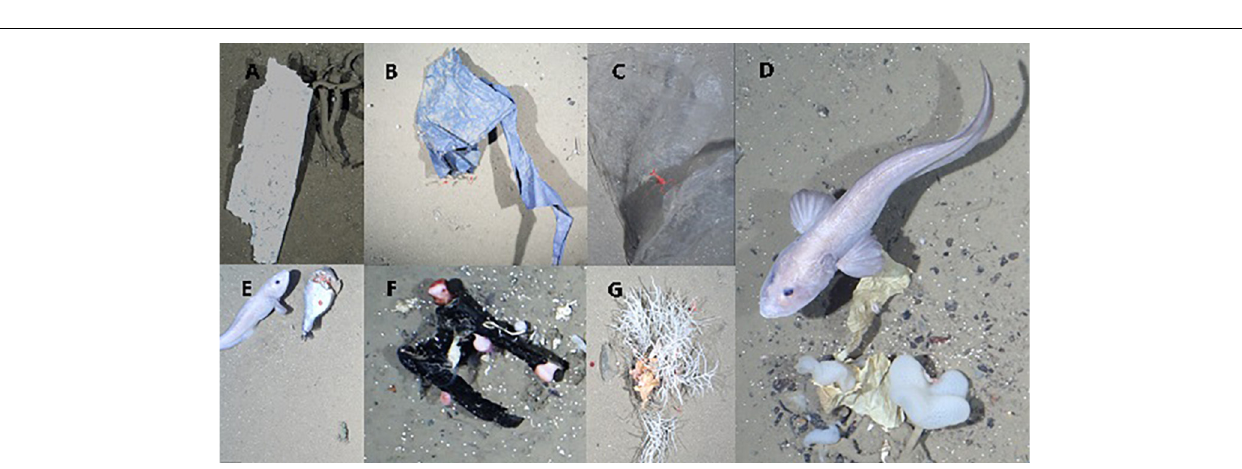
FIGURE 3 | Size composition of litter observed at the HAUSGARTEN observatory and at each station in terms of mean annual litter density between 2002 and 2017.